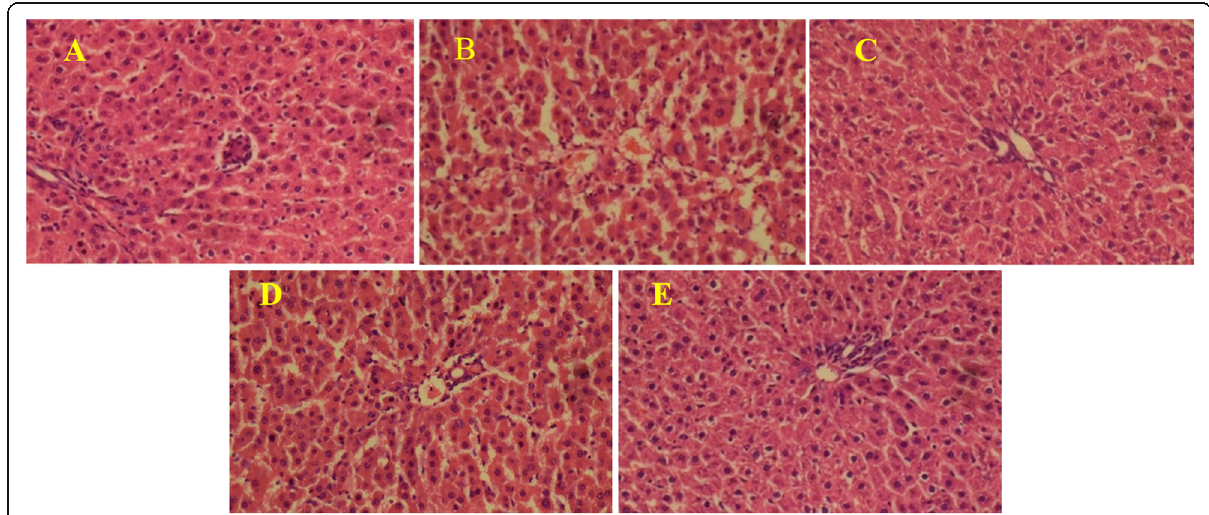
Fig. 4 Histological picture of liver architecture in CCl 4 induced hepatotoxicity in rat. a (Liver architecture of Normal control), b (Liver architecture of